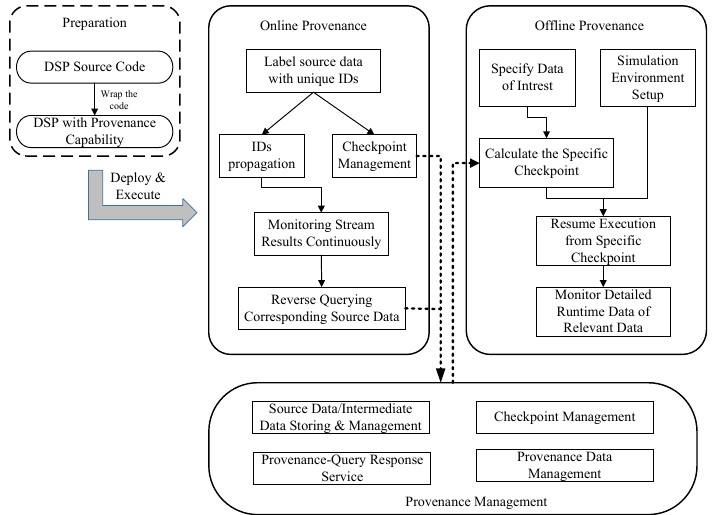
Figure 6. A framework for our DSP provenance